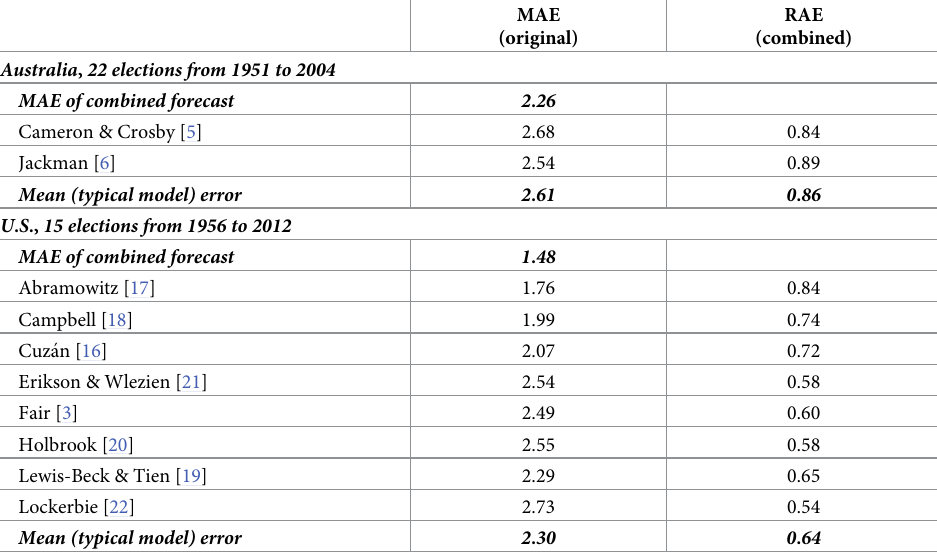
Table 3. Effect of combining on forecast errors relative to original forecast